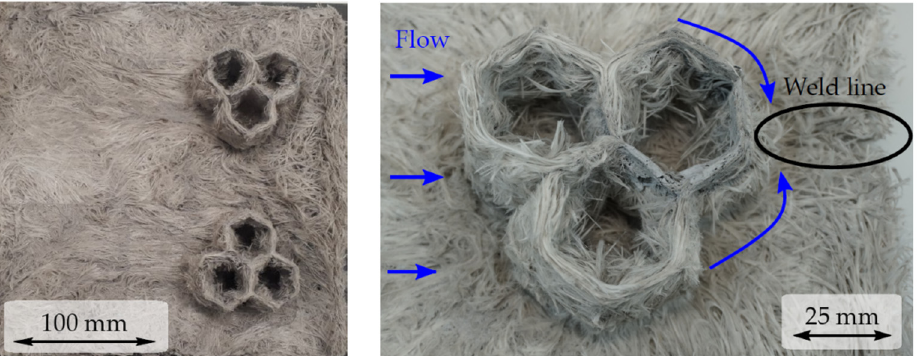
Figure 11. ( a ) Residue of the complete part molded with Configuration A after burning of the organic Figure 11. compounds. The thin and thick honeycombs are positioned in the lower and upper part of the picture, respectively. ( b ) Residue of a thick honeycomb molded with Configuration B after burning of the organic compounds. The coupon under consideration is the upper left cell.